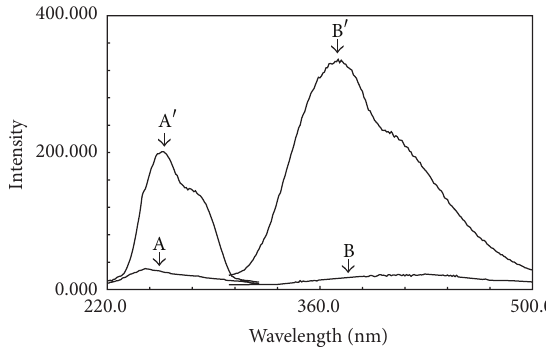
Figure 1: Fluorescence spectra of (A, B) hydrochloric acid buffer of pH 1.2 and (A 󸀠 , B 󸀠 ) ganciclovir (1.1 𝜇 g mL −1 ) in hydrochloric acid buffer of pH 1.2. Where: (A, A 󸀠 ) are the excitation spectra and (B, B 󸀠 ) are the emission